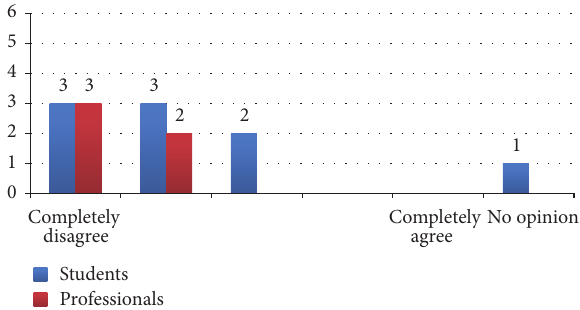
Figure 10: Statement: the result of ECW/PUEA is independent of the prior knowledge of the analysts.